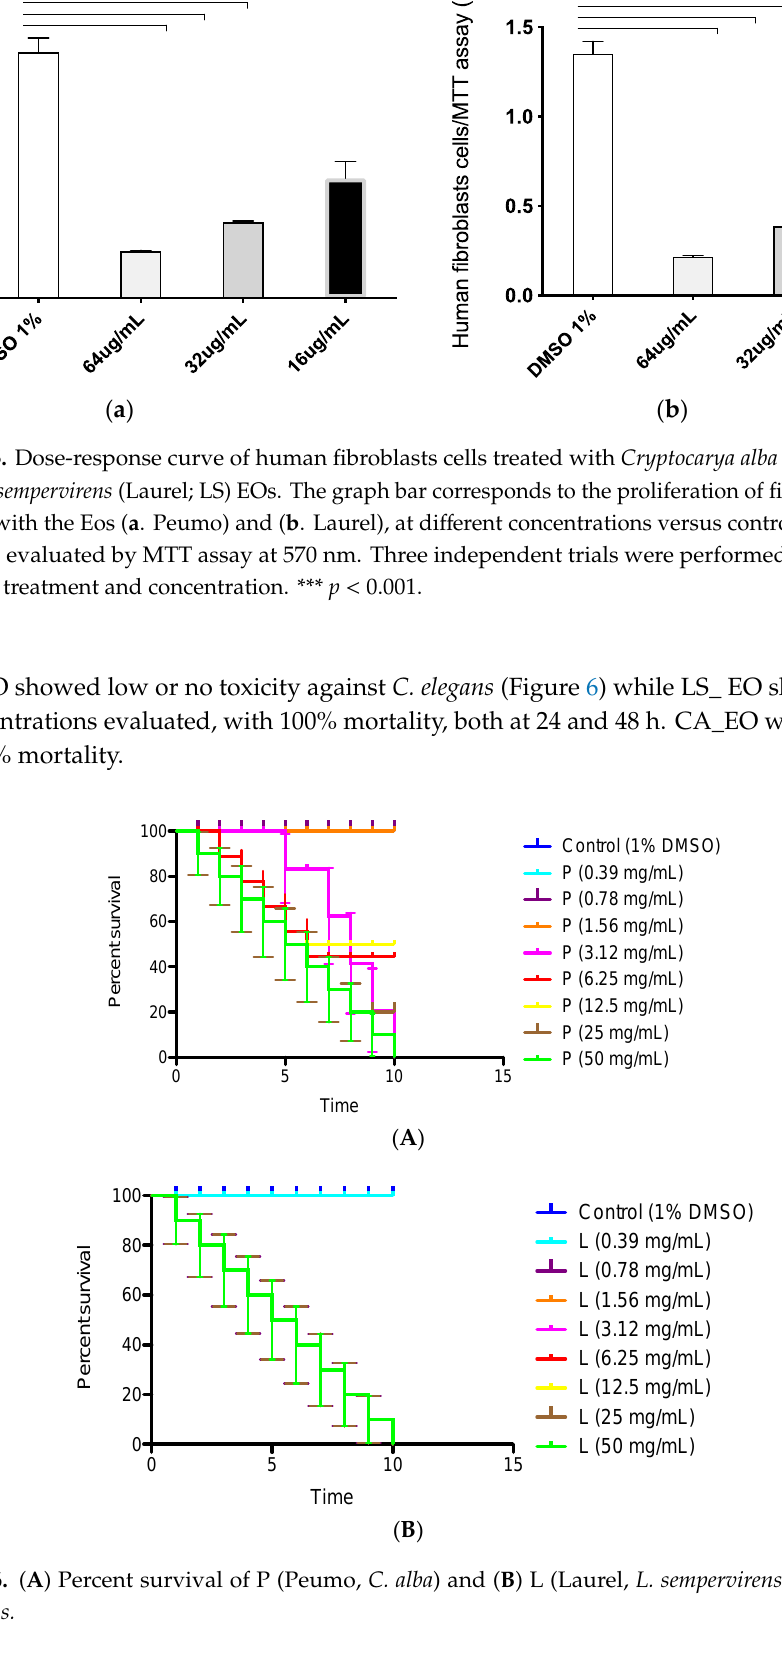
Figure 4. Dose-response curve of human glioblastoma cells tumor cell line U87MG treated with Cryptocarya alba (Peumo; CA); Laurelia sempervirens (Laurel; LS) EOs. The graph bar corresponds to the proliferation of U87GMtreated with the Eos (a. Peumo) and (b. Laurel), at different concentrations versus control (DMSO 1%) for 48 h, evaluated by MTT assay at 570 nm. Three independent trials were performed, in triplicate, for each treatment and concentration. *** p < 0.001.